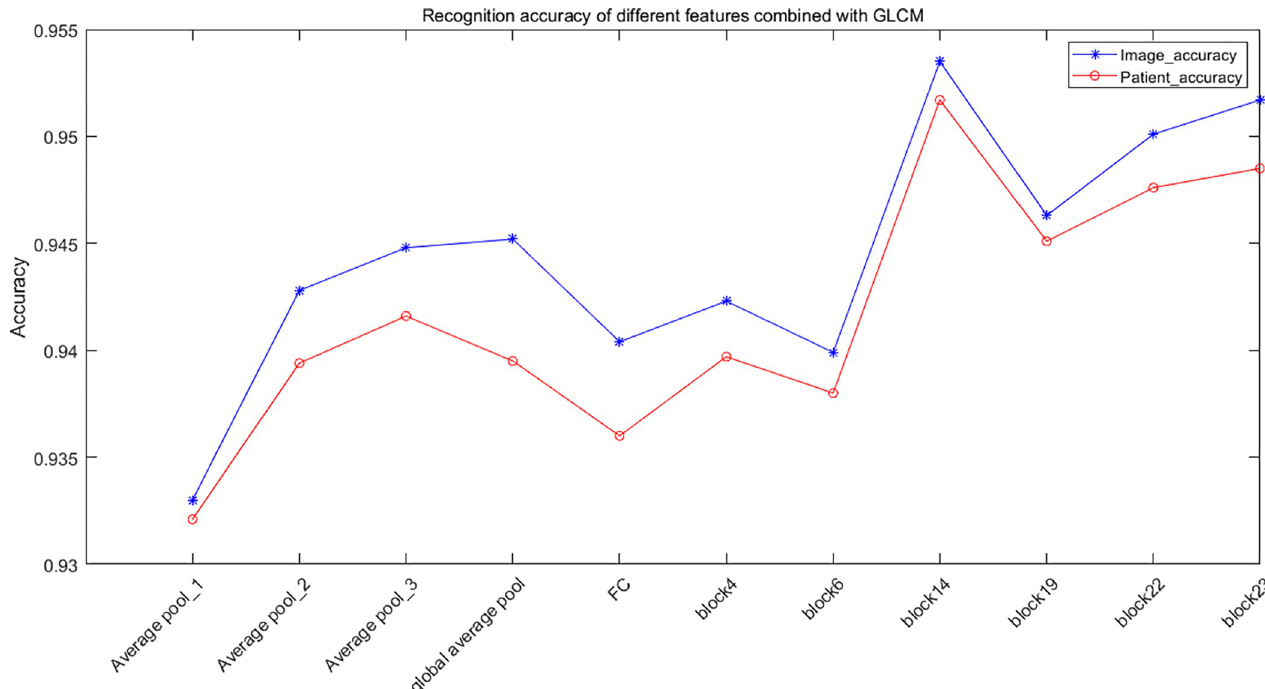
Fig 4. Recognition accuracy of different features combined with